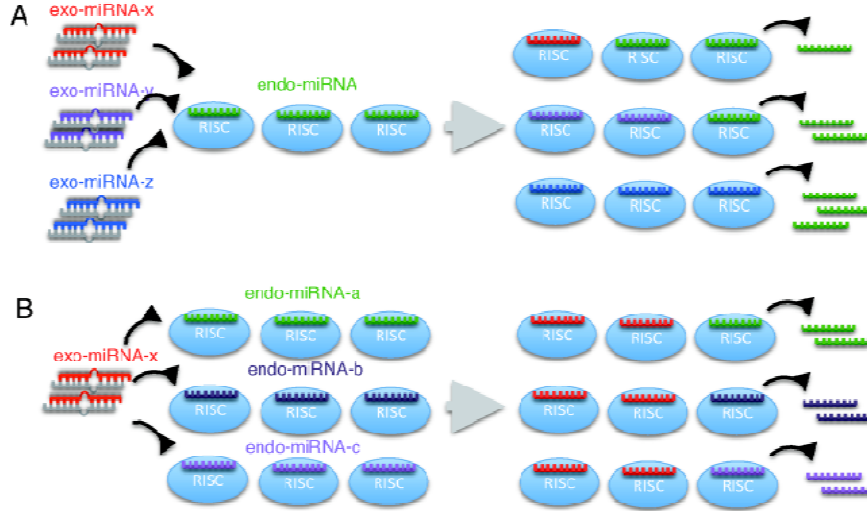
Figure 7. Predicted model for the RNA-induced silencing complexes (RISCs)